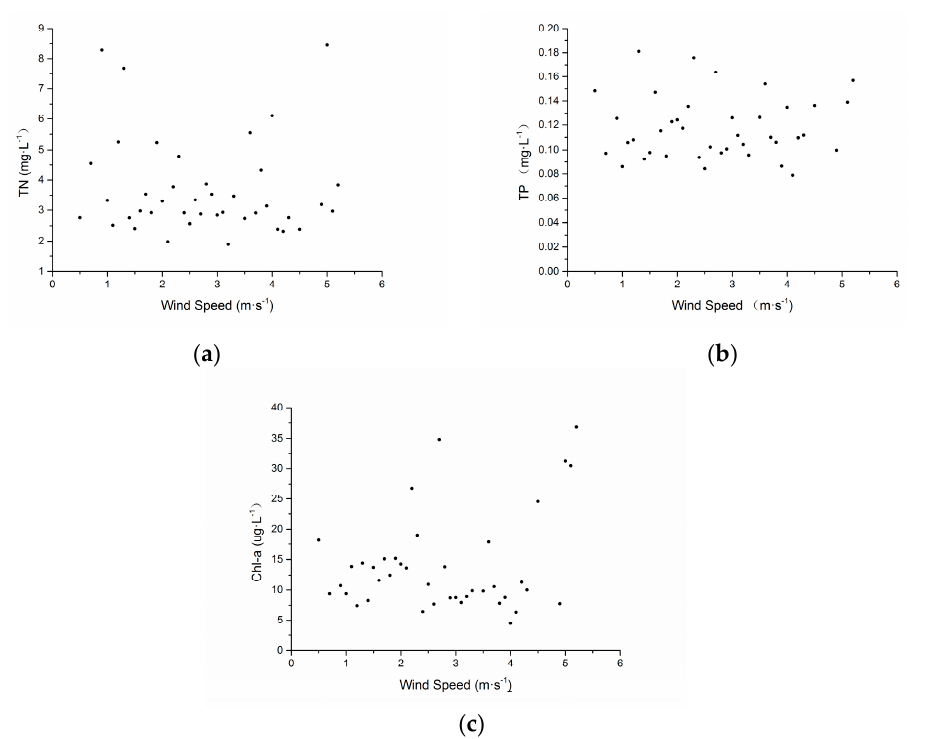
Figure 11. Plots showing wind speed versus median concentration of: ( a ) total nitrogen (TN); ( b ) total phosphorus (TP); and ( c ) chlorophyll-a (Chl-a), in the bays (namely Zhushan Bay, Meiliang Bay and Gonghu Bay in Figure 1).